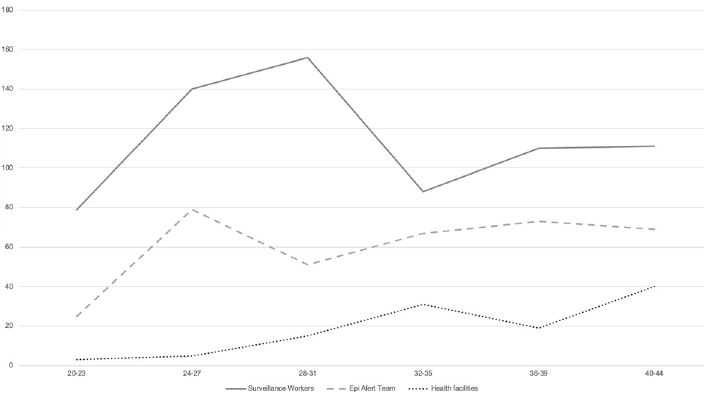
Fig 5. Trends in suspected AJS cases compared between two MSF health facilities, surveillance workers and Epi Alert Team in Cox’s Bazar, Bangladesh, week 20–44,